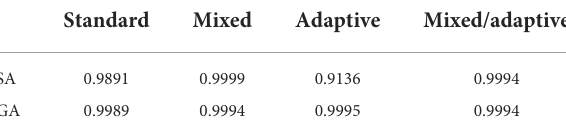
TABLE 3 Summary of peak average fitness between all four SA and GA cases on the α − pinene